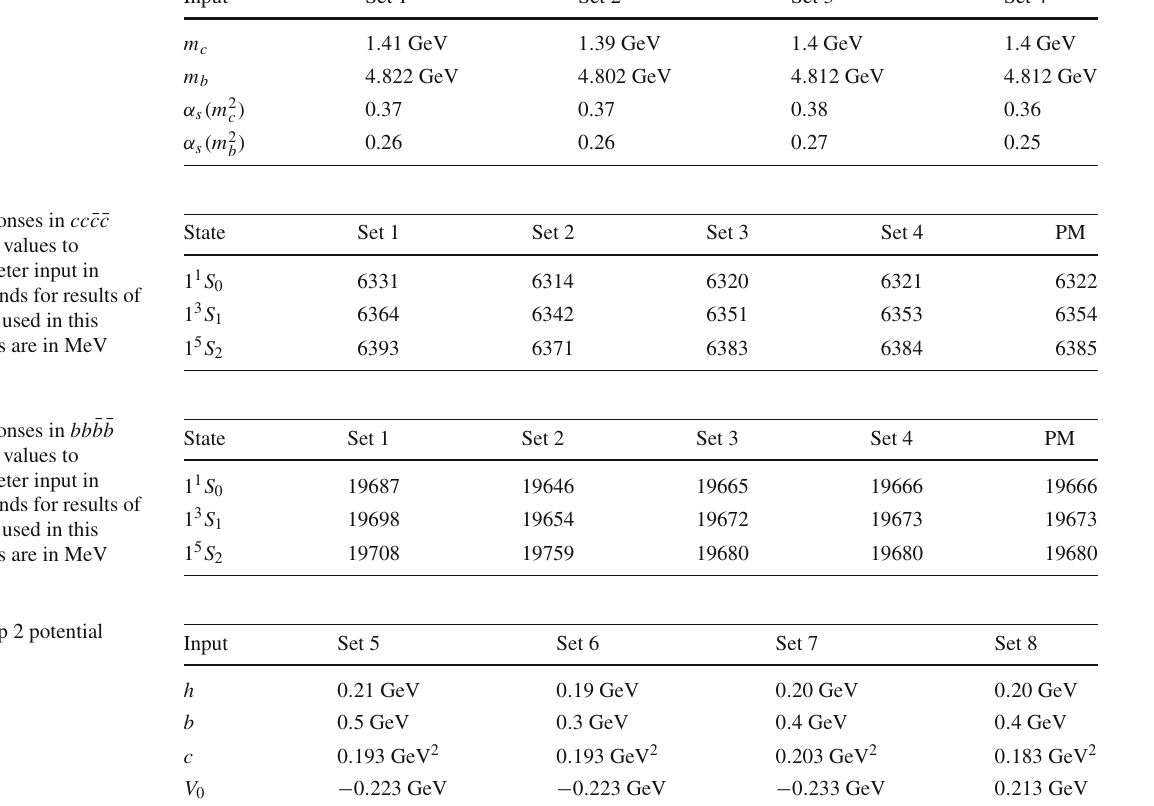
Table 10 Group 1 potential parameters